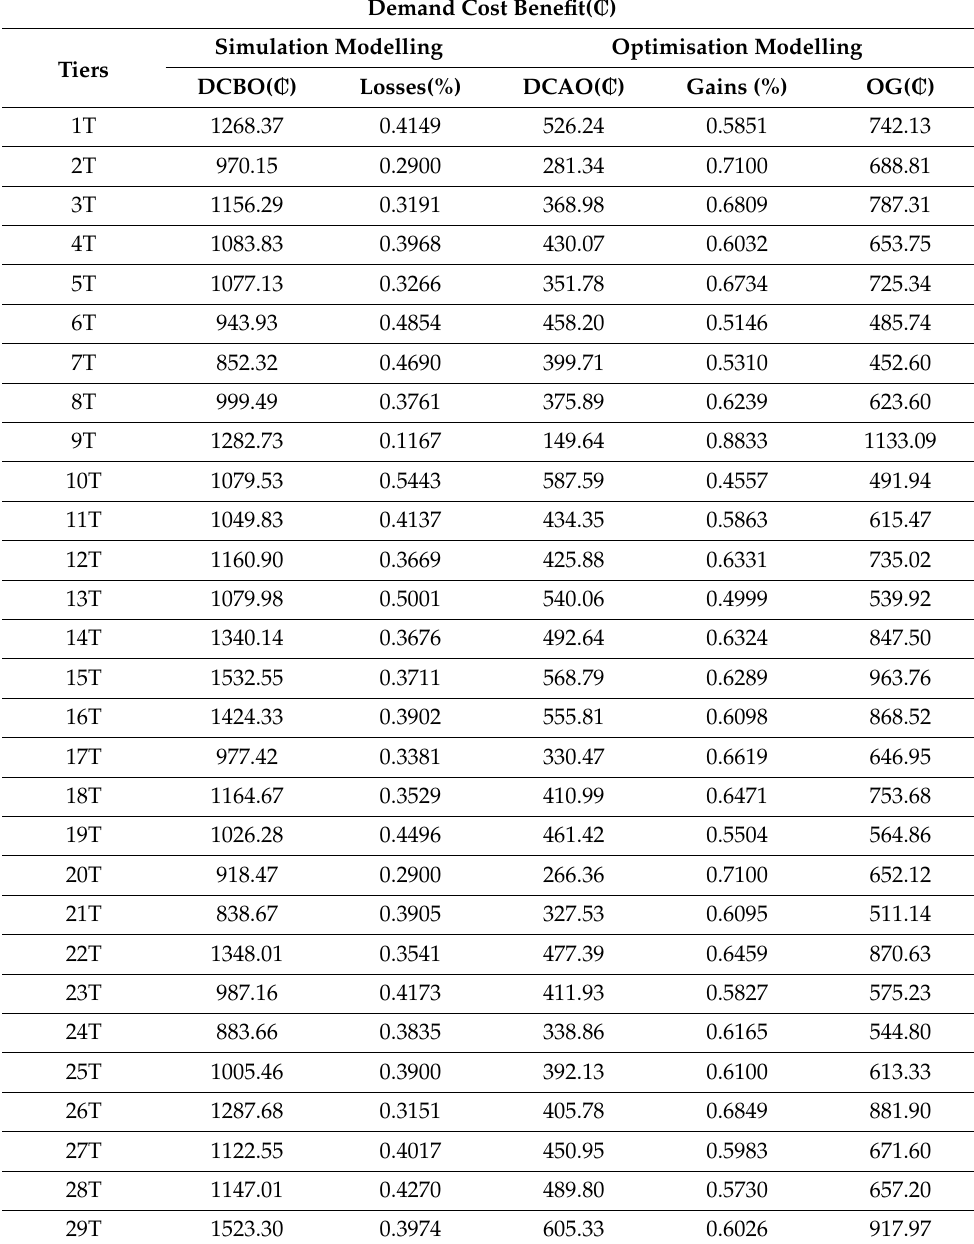
Table 7. Comparing Losses Cost of Simulation and